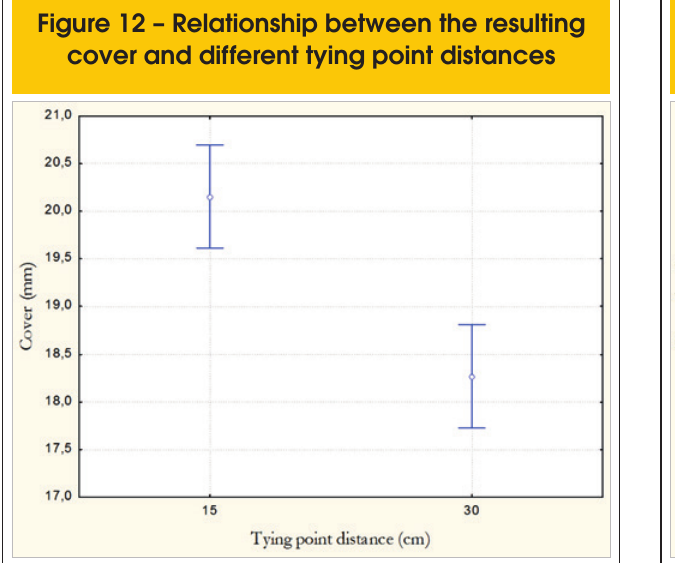
Figure 13 – Relationship between the resulting cover and the distance between